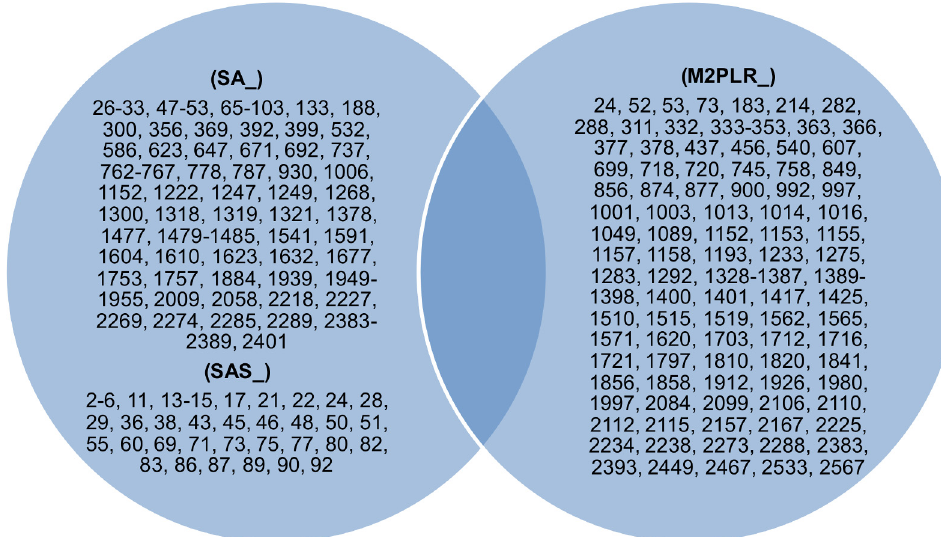
Fig 3. Venn diagram showing unique genes between N315 and M2 (SA or M2PLR